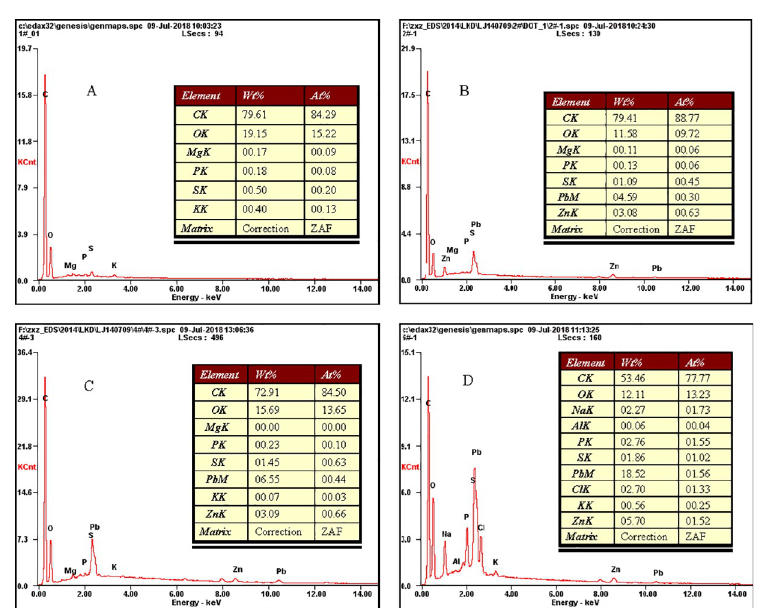
Fig 6. EDS of growing Verticillium insectorum J3 under different Pb(II) and Zn(II) concentrations. (a) metal-free hypha (control); (b), (c), (d) metal-loaded hyphae (100, 200, 300 mg L -1 , respectively). Biosorption conditions: initial pH = 4, initial Pb(II) and Zn(II) concentration (0, 100, 200, 300 mg L -1 , respectively), absorption time 7 days, initial biomass does 2mL L -1 , temperature 30˚C.